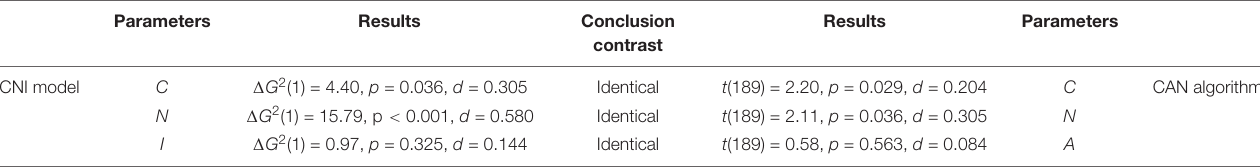
TABLE A8 | Test of differences in harm salience with the CNI model and CAN algorithm in Study S1b by Gawronski et al. (2017).